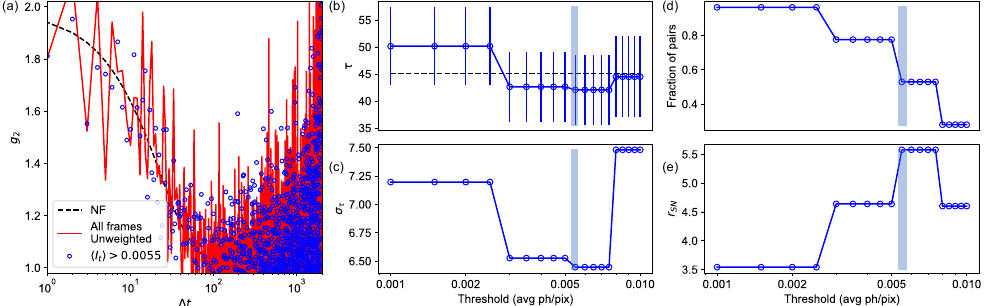
Figure 6. Reducing the noise and uncertainties in the determination of g 2 for XFEL data simulated using the Gamma intensity distribution. ( a ) The g 2, SIM calculated from all the speckle patterns (red curve) and only from those with a threshold of over 0.02 photon/pixel on average (blue symbols). ( b , c ) The characteristic time scale τ SIM and its standard deviation σ τ extracted from g 2, SIM as a function of the applied intensity threshold, in units of average photon number/pixel.( d , e ) The fraction of two-time pairs at ∆ t = 1 and the extracted SNR r SN as a function of the applied intensity threshold.